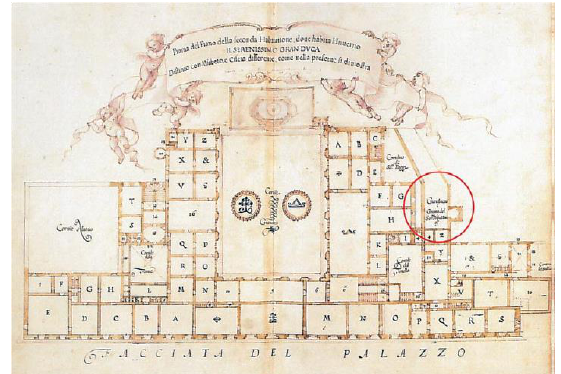
Figure 1. Giacinto Maria Marmi, Pianta della Seconda Habitazione, dove Habita l’inverno il Serenissimo Gran Duca, 1662 c. Firenze, Biblioteca Nazionale, Magliab.